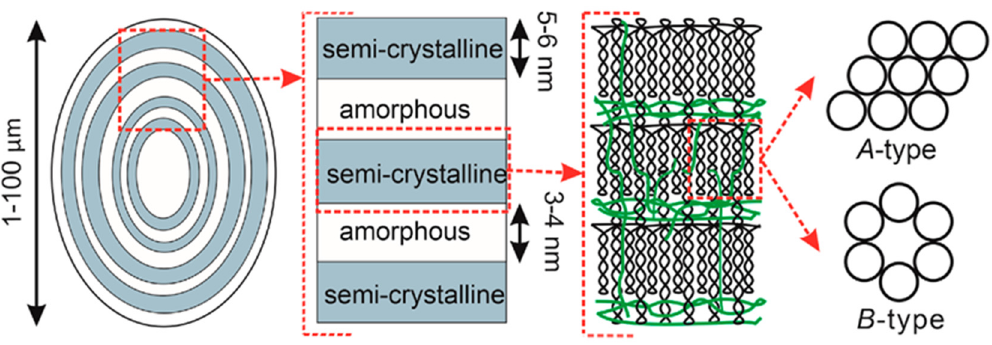
Figure 2. Starch structure illustration form to the unit of glucosyl; black lines represent the branched part and double helices of amylopectin, while green lines represent the single helices of amylose, and the double helices in an A-type or B-type polymorphic crystal from the top view are indicated by circles [9].